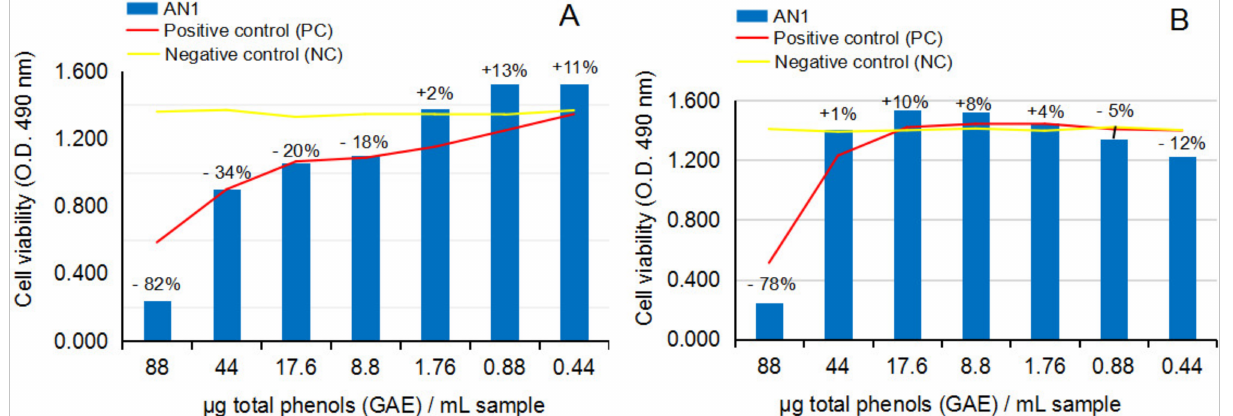
Figure 7. Effect of crude ethanolic extract from fresh Anemone nemorosa L. plant material (AN1) on human tumor brain cell line U87, in anti-proliferative MTS assay. ( A ) U87 cell line viability after 24 h of exposure to test vegetal extract AN1; ( B ) U87 cell line viability after 48 h of exposure to test vegetal extract AN1. All determinations were made in triplicate series, and the results are calculated as an average. The graphs present the percentage of the cell viability in series by comparison to positive control sample (CP) series. According to statistical calculation, the results on the U87 cells at 24 h and 48 h were not statistically significant ( p >